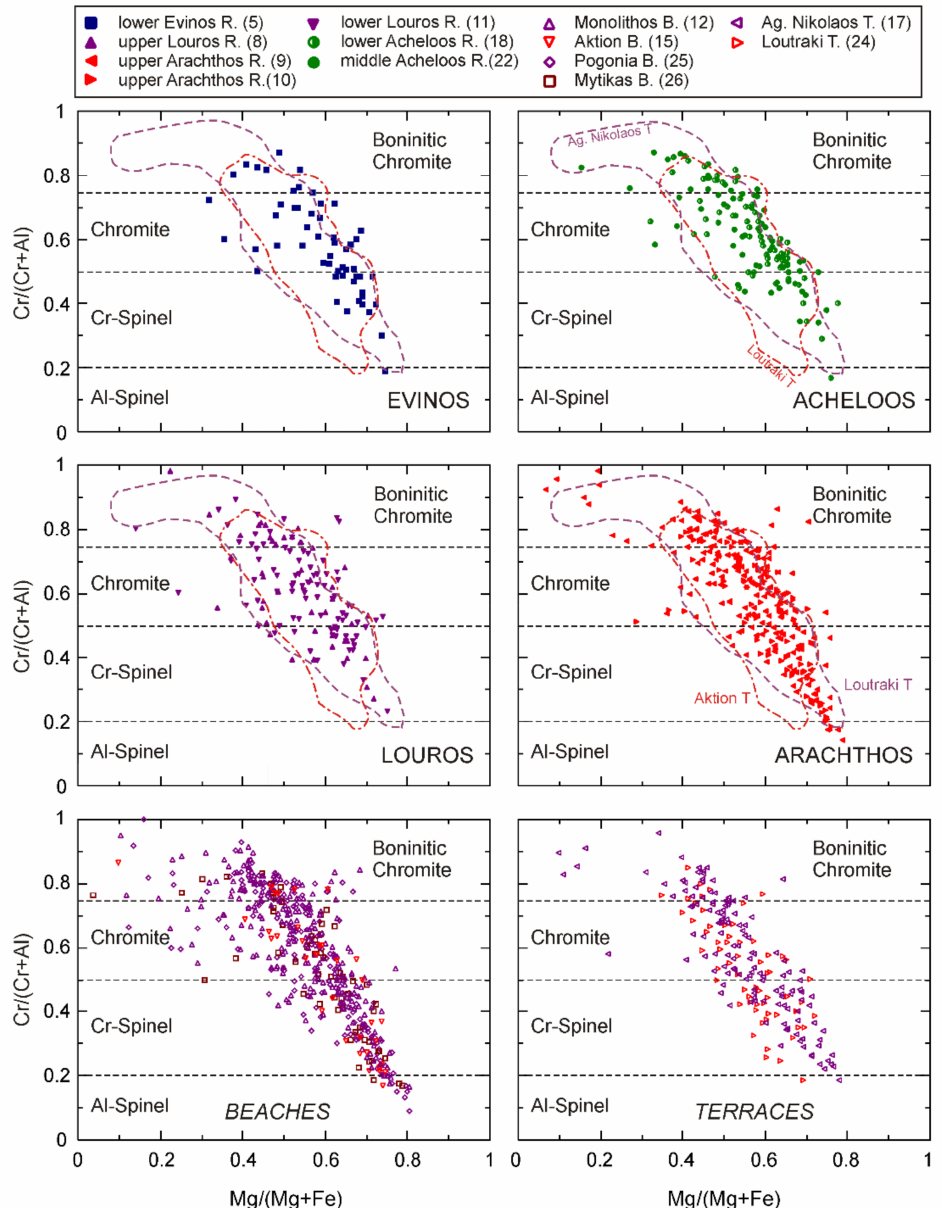
Figure 7. Plot of Cr/(Cr + Al) vs. Mg/(Mg + Fe) showing chemical variation in chromite and spinel. Dashed lines in plots for river samples show the distribution limits in the Ag. Nikolaos and Loutraki terrace